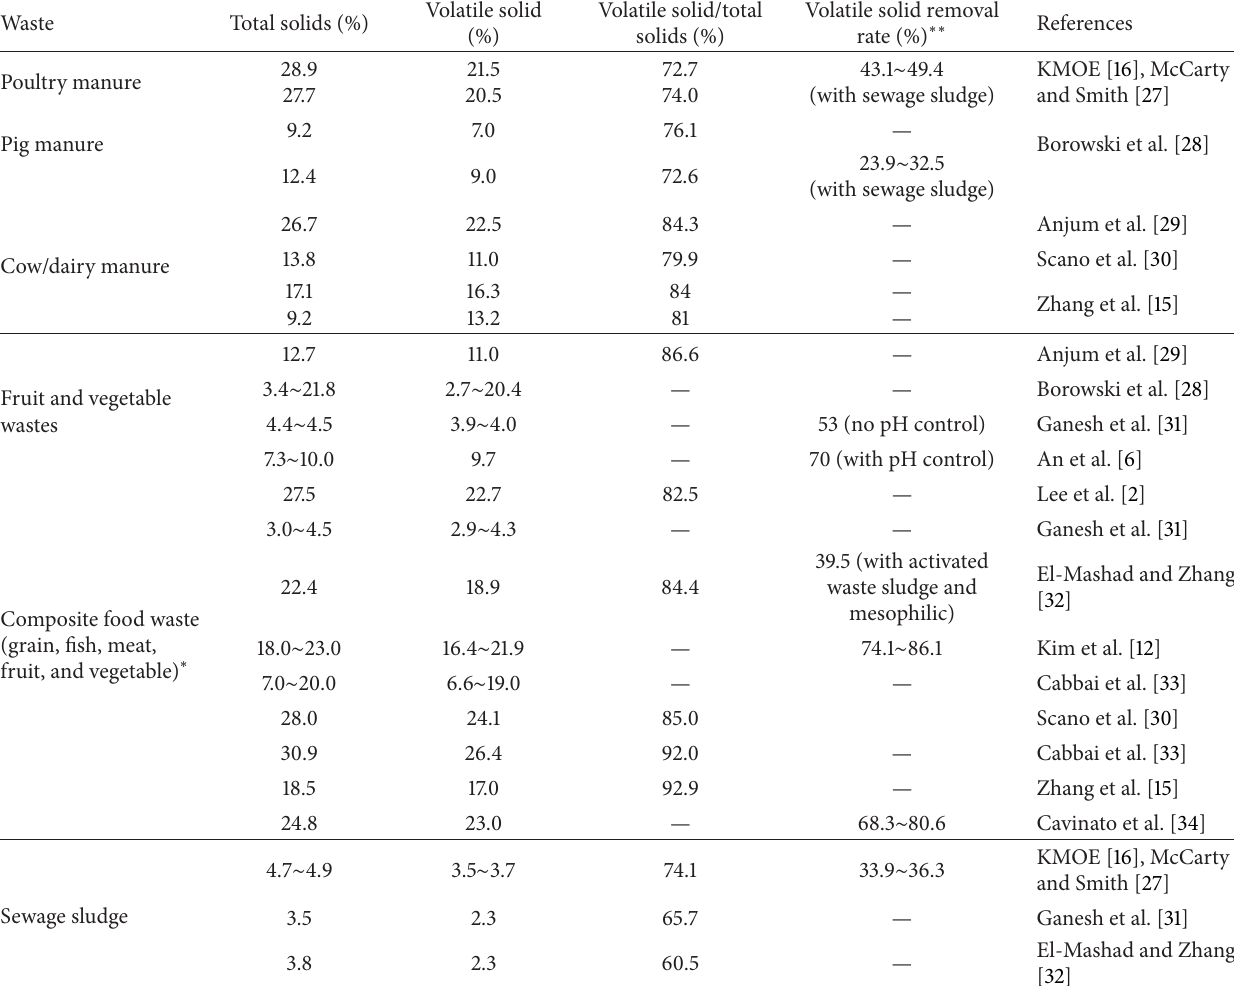
Table 3: Total and volatile solid of food waste, animal (poultry, pig, and cow) manure, and sewage sludge and their VS removal rates in the